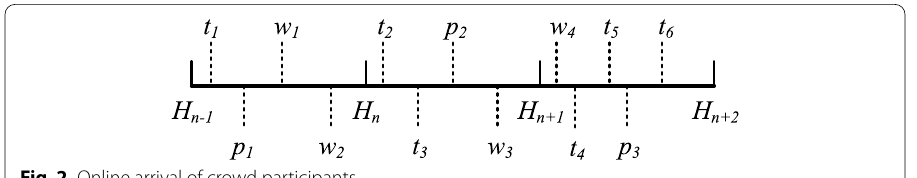
Fig. 2 Online arrival of crowd